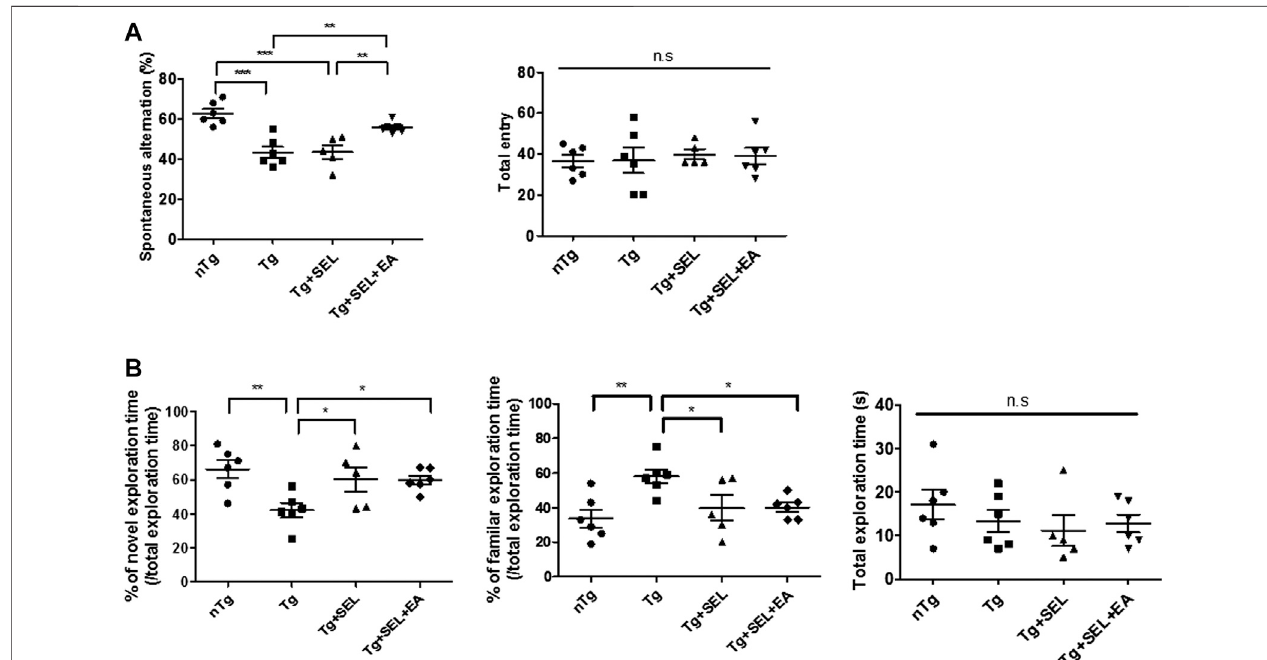
FIGURE 2 | Means ± SEM of the results of post-treatment cognitive tests in 5XFAD mice. (A) Spontaneous alternations and total entry during the Y maze test (n (cid:2) 5 – 6/group). (B) Percentageofexplorationtimeofthenovelorfamiliarobjectandtotalexplorationtimeduringthenovelobjectrecognition(NOR)test(n (cid:2) 5 – 6/group).* p < 0.05;** p < 0.01;SEM,standarderrorofmean;nTg,non-transgenicmicegroup;Tg,5XFADmicegroup;Tg+SEL,selegiline-treated5XFADmicegroup;Tg+SEL+EA, 5XFAD mice group treated with selegiline combined with electroacupuncture; n.s, not signi fi cant.